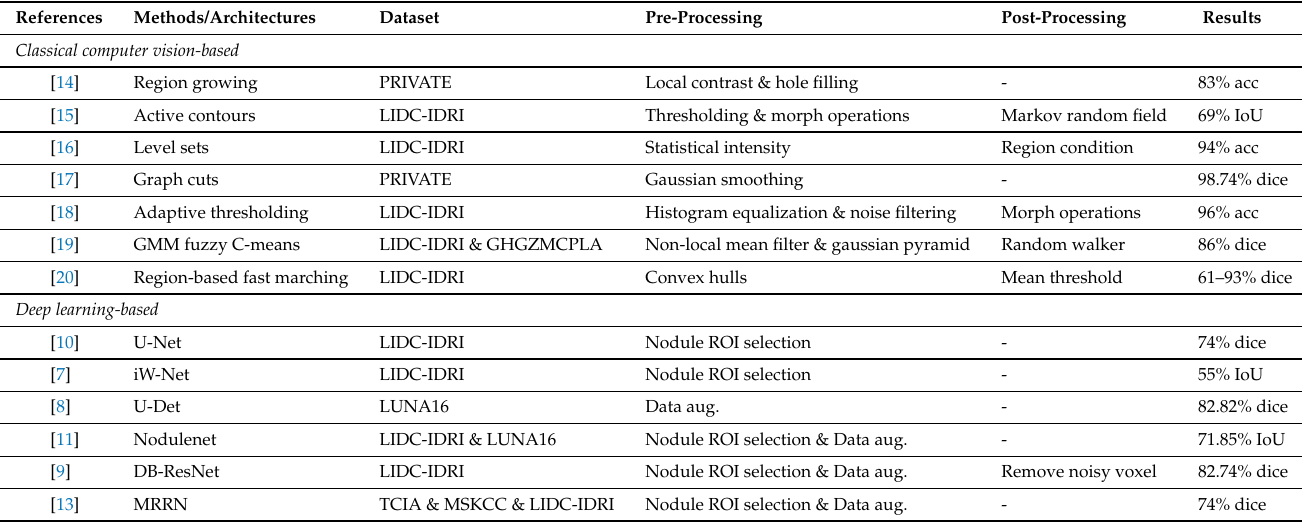
Table 1. Summary of existing lung nodule segmentation methods. The undeclared information is marked with dashes (-) in the referred literature. Aug., morph, acc and IoU stand for augmentation, morphological, segmentation accuracy and intersection over union,